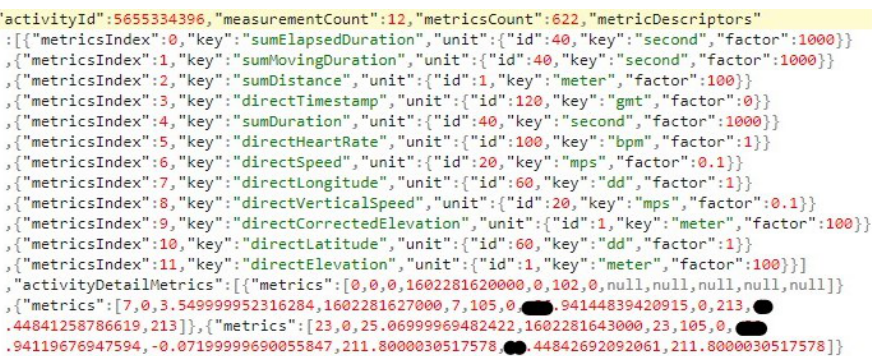
Figure 18. Reduced activity chart data detailing the GPS path the user took during a walk. The GPS coordinates have been partially redacted for user